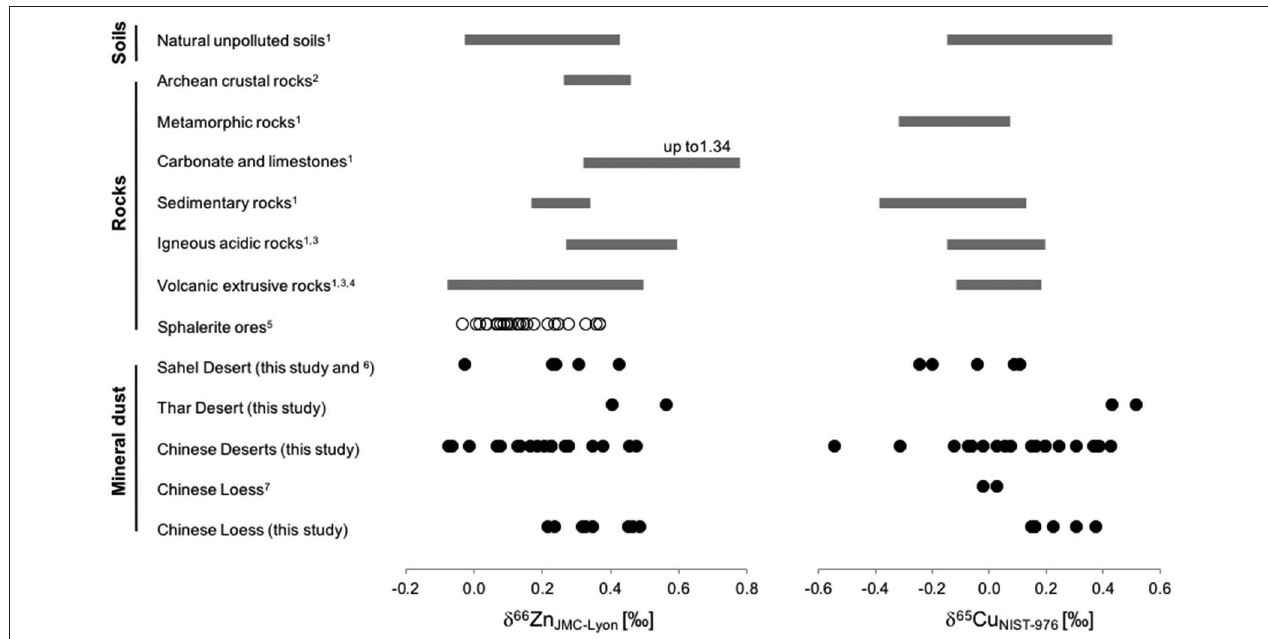
FIGURE 5 | Comparison of measured isotope ratios of Zn (left panel, expressed as δ 66 Zn JMC − Lyon ) and Cu (right panel, expressed as δ 65 Cu NIST − 976 ) in natural reservoirs (References: 1. Fekiacova et al., 2015; 2. Doucet et al., 2018, 3. Cloquet et al., 2008, 4. Herzog et al., 2009, 5. Sonke et al., 2008, 6. Dong et al., 2013, 7. Li et al., 2009). Note: Mineral dust from this study includes data from different particle size